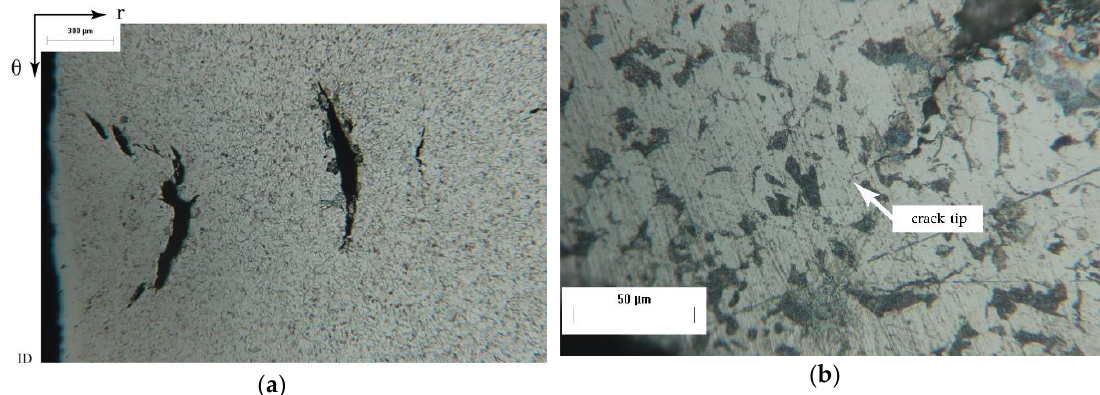
Figure 8. ( a ) HIC cracks at location 577; ( b ) tip of HIC crack indicating propagation in ferrite between pearlite colonies.